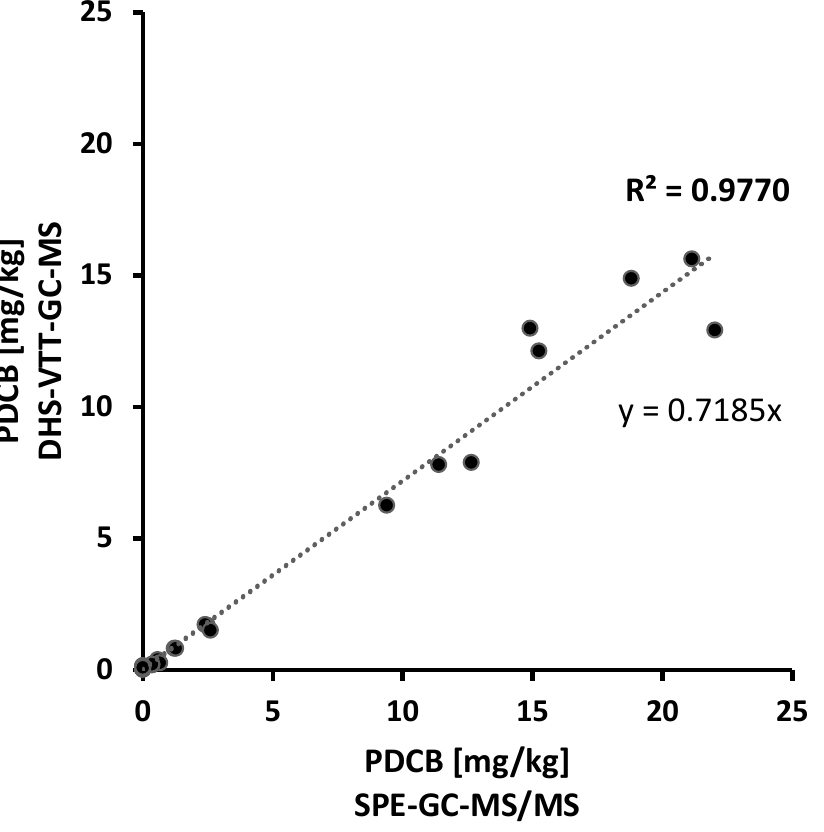
Figure 2. Quantitation of PDCB in wax samples (N = 17) by SPE-GC-MS/MS analysis (x-axis) versus DHS-VTT-GC-MS analysis (y-axis) using external calibration.